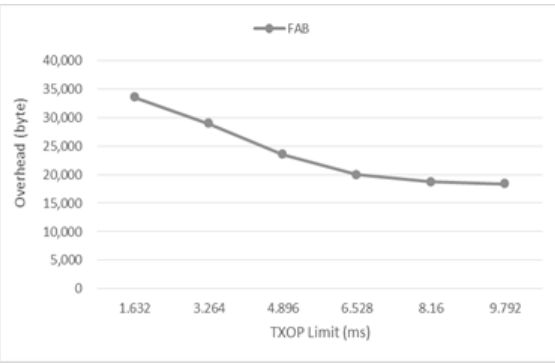
Fig. 9. Relationship between TXOP limit and